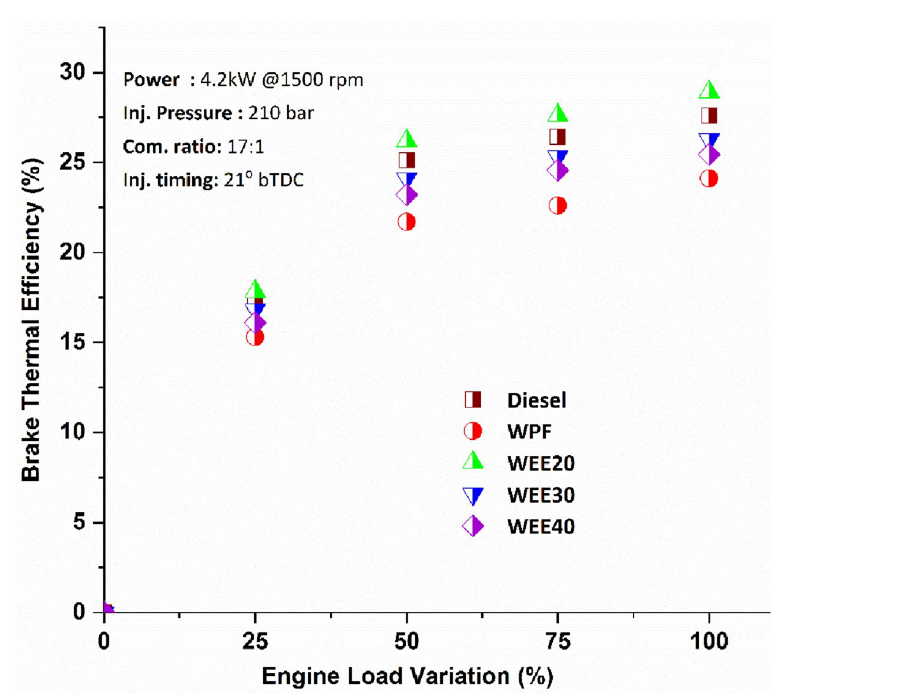
Figure 2. Performance of Brake thermal efficiency on engine